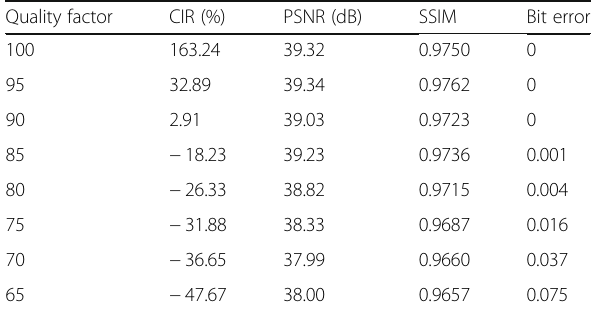
Table 1 Different quality factors for the Green bamboo image Quality factor